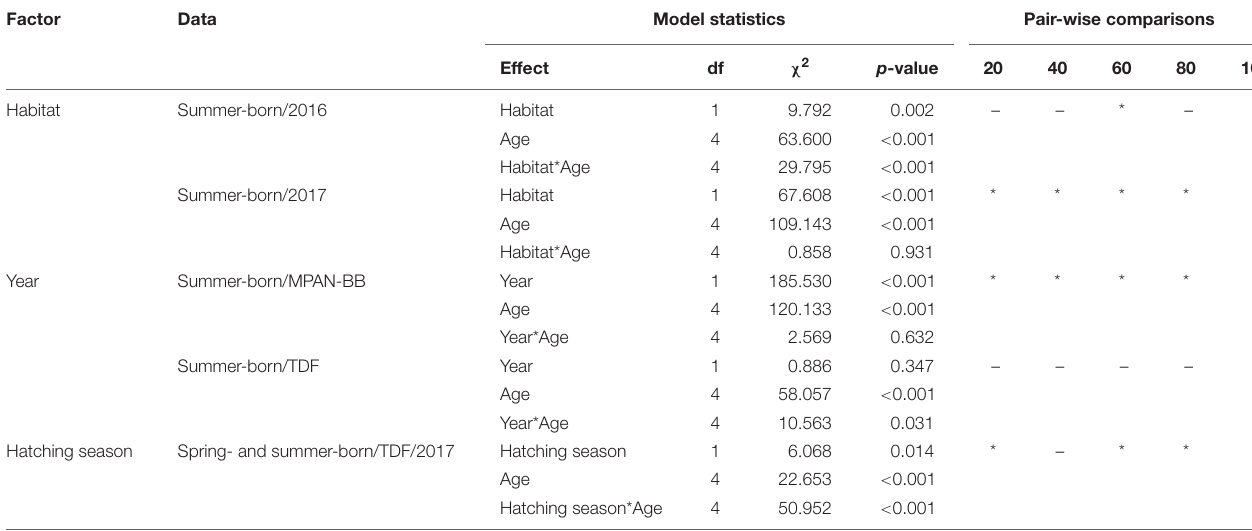
TABLE 5 | Results of repeated measure analyses of daily growth rates at 20, 40, 60, 80, and 100 days of age of Fuegian sprats Sprattus fuegensis in the Marine Protected Area Namuncurá-Burdwood Bank (MPAN-BB) and Tierra del Fuego (TDF). Factor